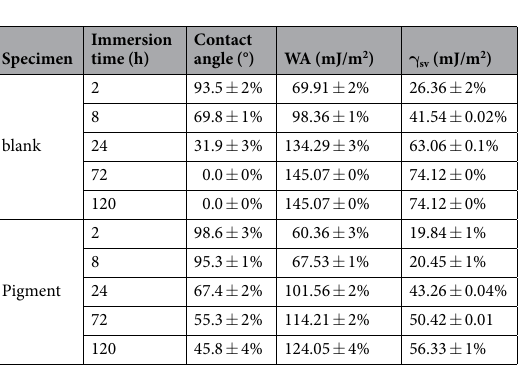
Table 3. The values of CA, WA, and γ sv for the AA2024-T3 immersed in 3.5 wt.% NaCl solution (blank) and the Ce-DEDTC pigment extract saline solution (Pigment) after various soaking